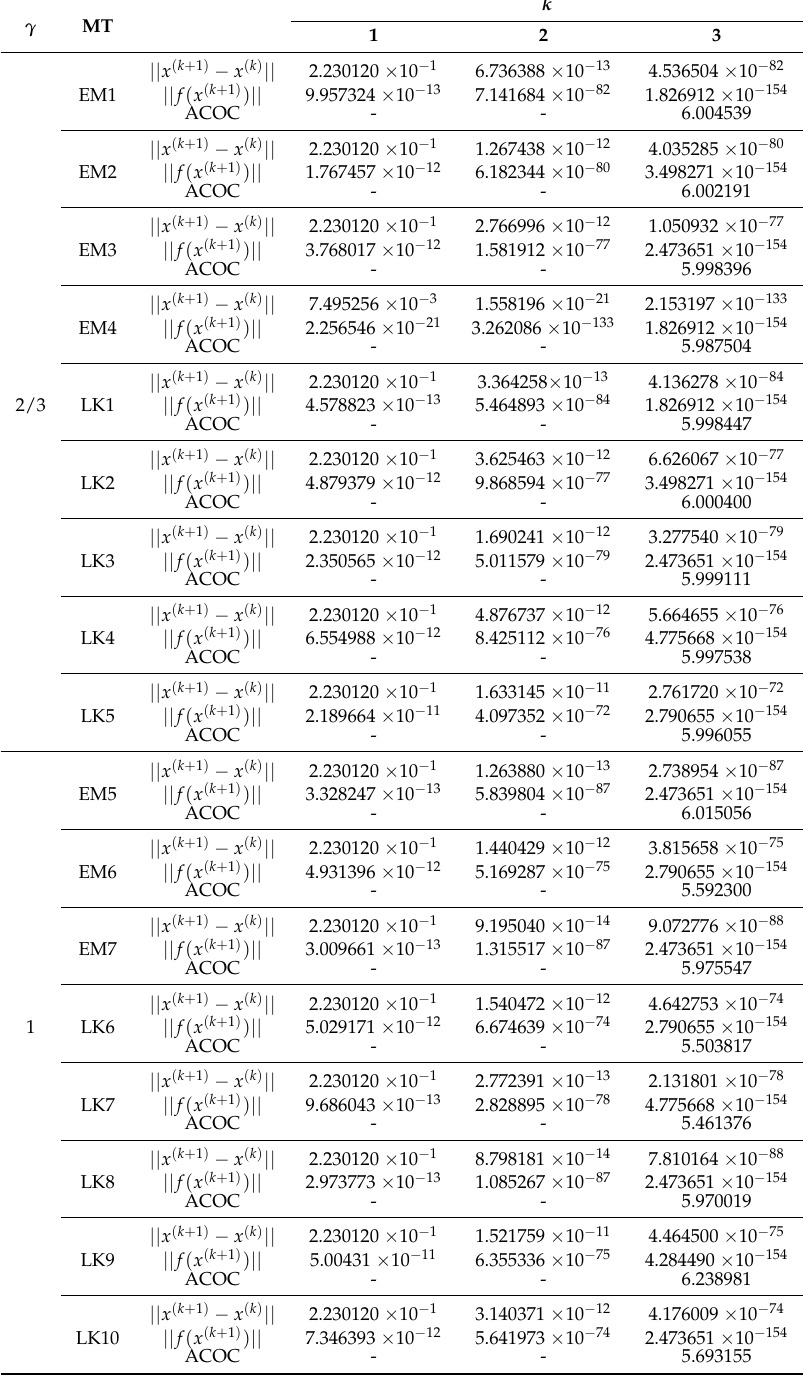
Table 7. Convergence results of Test Example